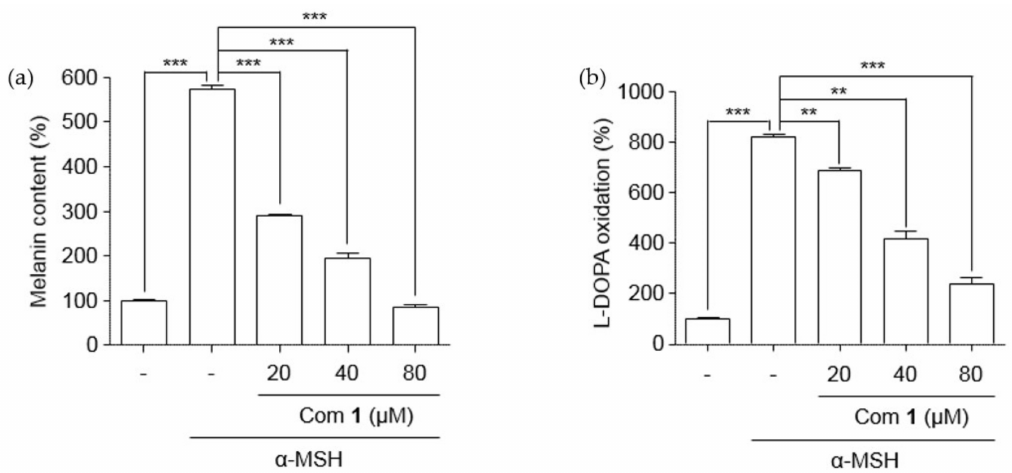
Figure 7. E ff ect of lowering ( a ) melanin content and ( b ) l -DOPA oxidation in B16F10 mouse melanoma cells. B16F10 cells were treated with di ff erent concentrations of compound 1 for 48 h in the presence of α -MSH. Data are represented as % of control, and each column indicates the mean ± standard error (SE) of the three determinations ( n = 3); ** p < 0.01, *** p < 0.001. Compound 1 represents component 1 . Table 2. E ff ects of compound 1 on cell growth and melanin production of B16 cells. Melanin Synthesis IC Compounds